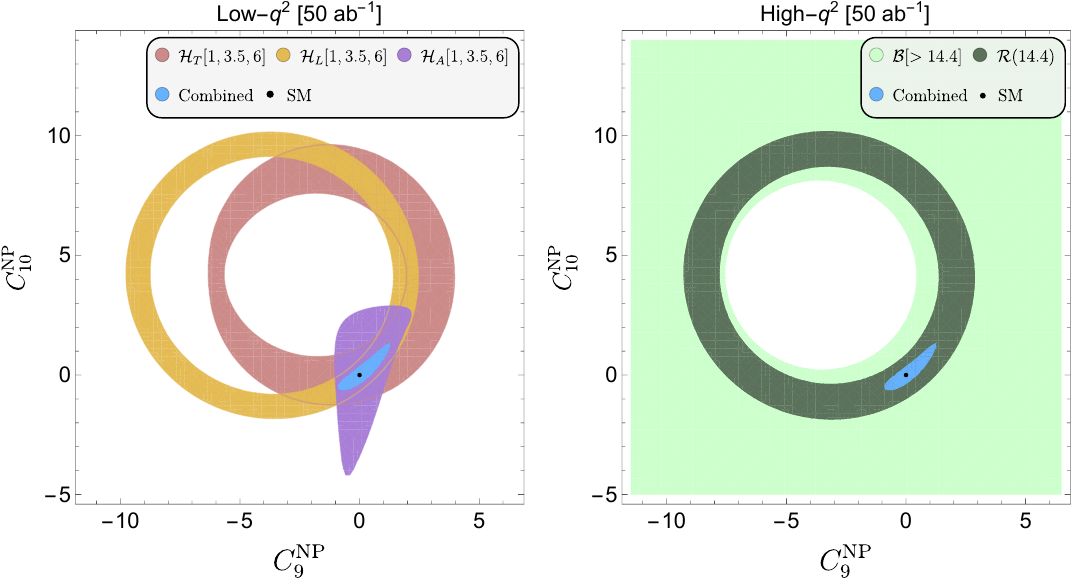
Figure 4 . Breakdown of the projected constraints at low- and high- q 2 . See the caption in (cid:12)gure 2 for further details.